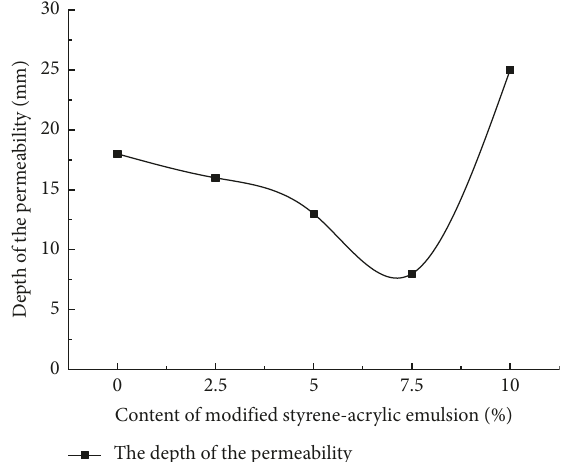
Figure 13: Influence of modified styrene-acrylic emulsion pa- rameters on the impermeability of the cement slurry forming test